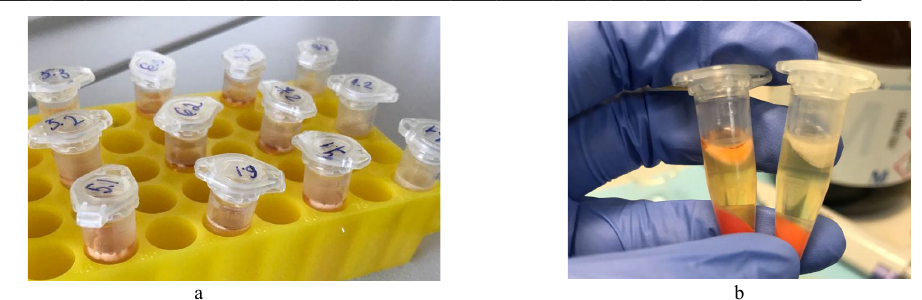
Fig. 3. Released dark orange substance on the surface of the broth in samples with Tween 20 at the concentration: a) 3 %, 4 %, 5 %; b) 5 % Tween 20 compared with 5 % Tween 80.